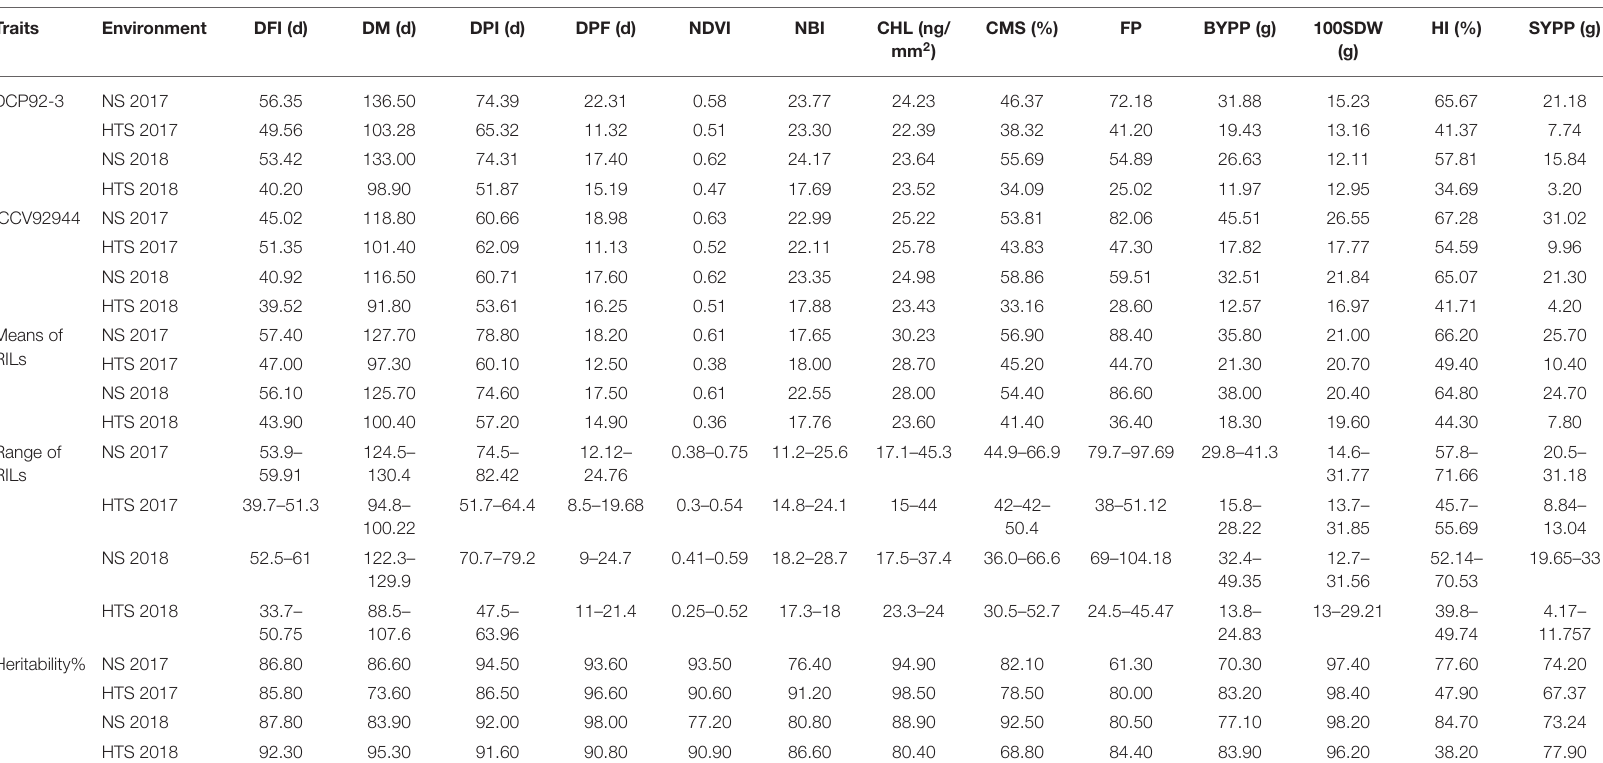
TABLE 1 | Phenotypic performance of heat sensitive (DCP 92-3), tolerant (ICCV 92944), RILs, and heritability of traits evaluated under normal and heat stress environments. Traits Environment